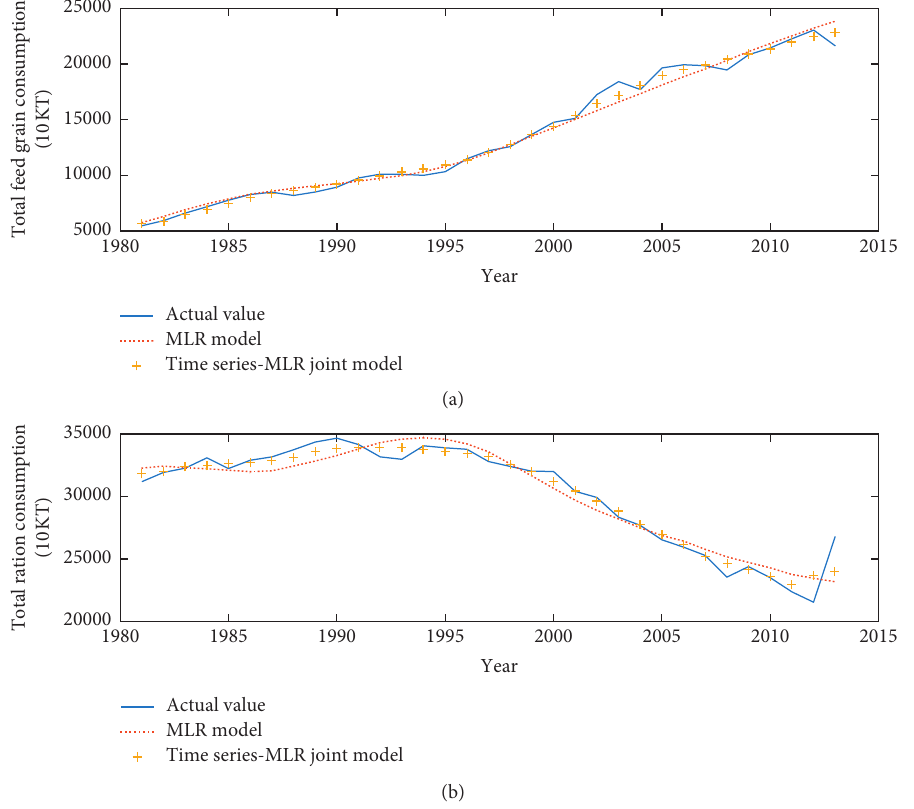
Figure 5: The fitting results of different models (1981–2013). (a) Feed grain consumption. (b) Ration consumption. Table 2: The fitting goodness of grain consumption trend. Grain consumption Ration Feed grain Predicted model R